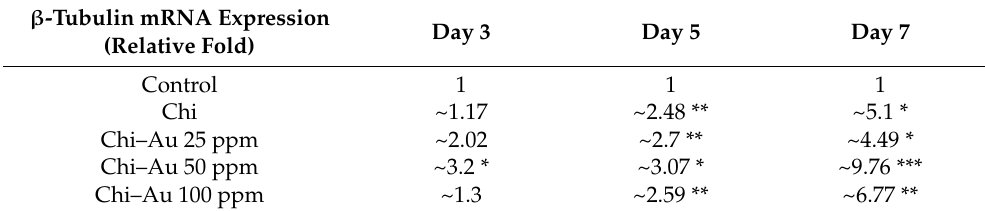
Table 2. β -Tubulin mRNA expression at 3, 5, and 7